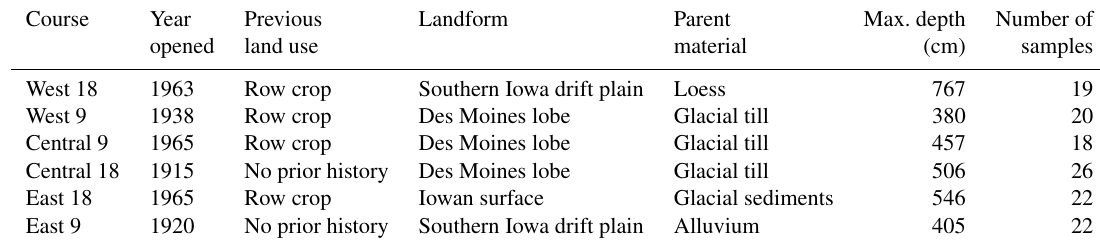
Table 1. Golf course site information.